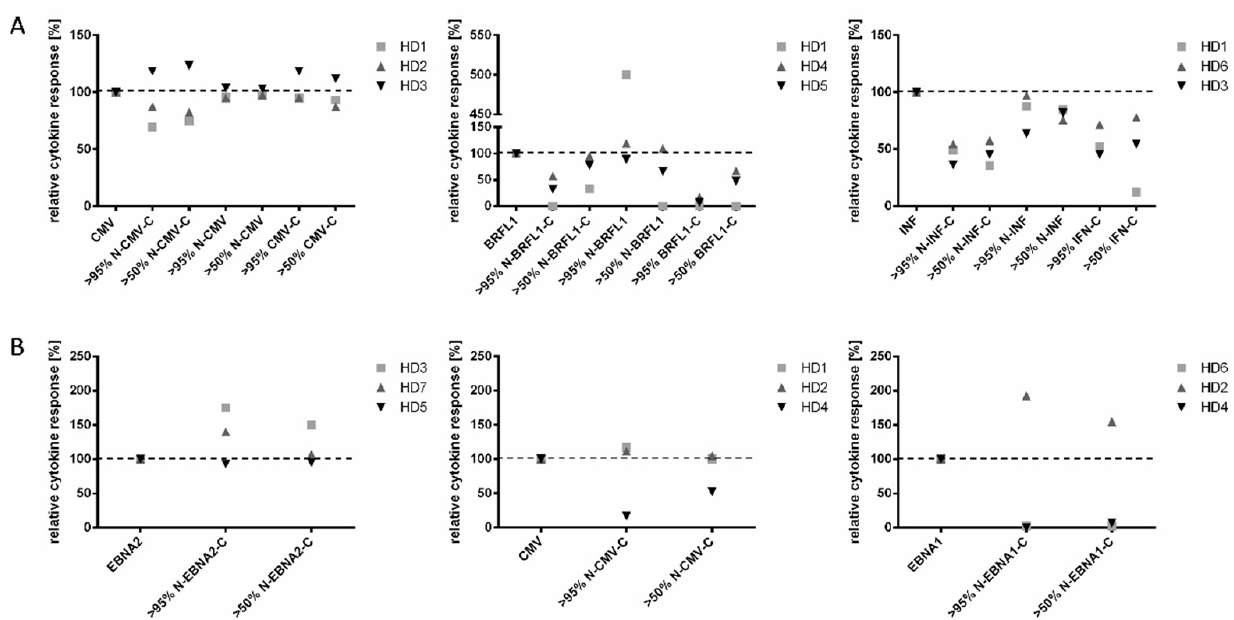
Figure 1. Ex vivo detection of virus-specific T cell responses using EPs can be suboptimal. PBMCs from healthy donors ( n = 7 HDs in total, n = 3 per specificity) were stimulated with 10 µg/mL HLA class I and class II viral-derived epitopes from CMV, EBV (BRFL1/EBNA1/EBNA2), and Influenza virus (INF) of short length, or with their respective EP version (20 mers, N-peptide source-C: N- and C-terminal elongated; N-peptide source: N-terminal elongated; peptide source-C: C-terminal elongated) for 12 h. Two EP purities (>50% and >90%) were used. The percentages of peptide-specific (background cytokine production in the negative control was subtracted) CD8 + ( A ) and CD4 + ( B ) cells that produced both cytokines (IFN- γ + TNF + ) were calculated. The anti-EP cytokine response is depicted related to the response to the matched short peptide (range 0.012–2.22% of IFN + TNF + cells within the CD4 + or CD8 + subsets), which is normalized to 100%. The full gating strategy is depicted in Figure S1A,B and frequencies of specific cells are given in Table